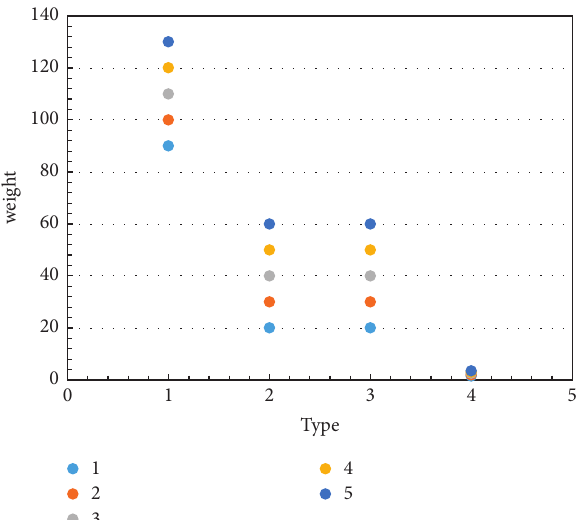
Figure 9: Preparation of biomass buffer packaging material